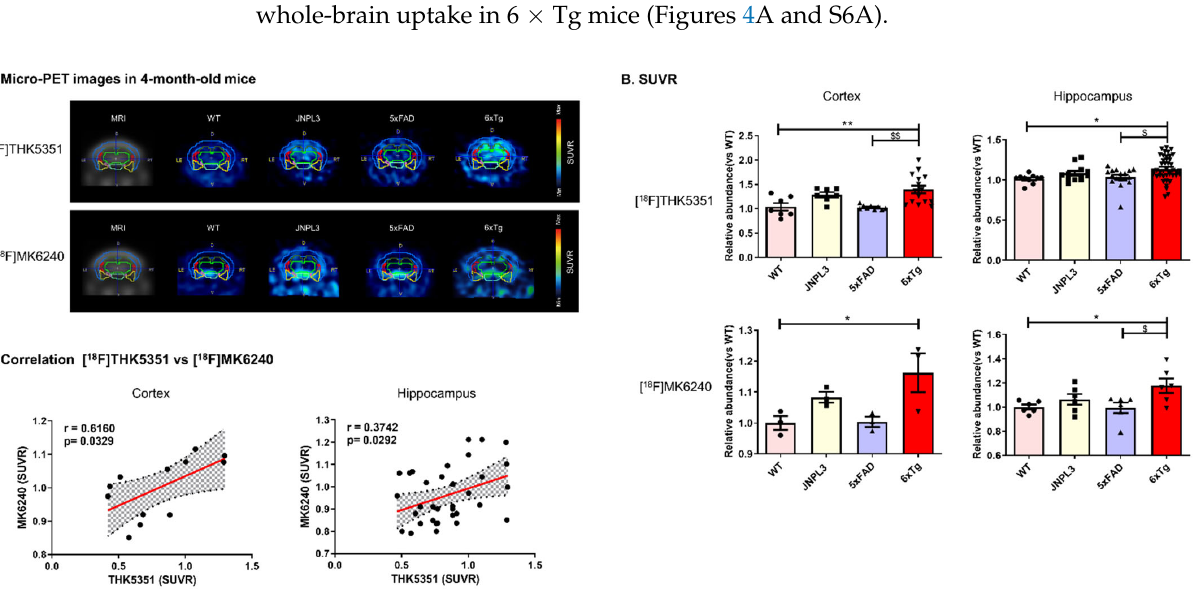
Figure 4. [ 18 F]THK5351 and [ 18 F]MK6240 uptake in the cortex and hippocampus of 4 ‐ month ‐ old 6 × Tg mice brains by in vivo microPET analysis. ( A ) MicroPET images of [ 18 F]THK5351 and [ 18 F]MK6240 radiotracers in the brain. Coronal microPET images summed over 50–60 min after [ 18 F]THK5351 or [ 18 F]MK6240 injection are shown for the WT, JNPL3, 5 × FAD, and 6 × Tg mice. ( B ) ROI ‐ to ‐ cerebellum ratios (ROI = cortex or hippocampus) from [ 18 F]THK5351 (a) or [ 18 F]MK6240 (b) data measured over 50–60 min are calculated for 4 ‐ month ‐ old WT, JNPL3, 5 × FAD, and 6 × Tg mice. Increased [ 18 F]THK5351 or [ 18 F]MK6240 retention is detected in the cerebral cortex and hippocam ‐ pus of 6 × Tg mice compared with that of WT or 5 × FAD mice, but signals in 6 × Tg mice exhibit no significant difference in tau deposition compared with that in JNPL3 mice. All data are presented as the mean ± SEM (n = 3–7 mice per group). Statistical analyses are performed using one ‐ way ANOVA followed by Fisher’s exact test. ** p < 0.01, * p < 0.05 vs. WT, $$ p < 0.01, $ p < 0.05 vs. 5 × FAD. ( C ) The correlation between [ 18 F]THK5351 uptake and [ 18 F]MK6240 uptake is assessed in the cerebral cortex and hippocampus of 6 × Tg mice using nonparametric Spearman’s rank correlation test. Graphs show regression lines with 95% confidence intervals. [ 18 F]THK5351 uptake was significantly correlated with [ 18 F]MK6240 uptake in both the cerebral cortex and hippocampus of 6 × Tg mice. Again, we focused on the mouse cortex and hippocampus. The difference in [ 18 F]THK5351 uptake in the cortex among the 2 ‐ , 4 ‐ , 6 ‐ , and 8 ‐ month ‐ old mice was ex ‐ pressed as the abundance relative to WT mice (Figure S6A). There was a significant in ‐ crease in the accumulation of [ 18 F]THK5351 in the cortex and hippocampus of 4 ‐ , 6 ‐ , and 8 ‐ month ‐ old 6 × Tg mice compared with that in age ‐ matched WT mice (Figure S6B). In addition, [ 18 F]THK5351 uptake in the cortex of 8 ‐ month ‐ old 6 × Tg (1.25 ± 0.01, *** p < 0.001 vs. WT, #### p < 0.001 vs. JNPL3) mice was significantly higher than that in age ‐ matched JNPL3 (1.20 ± 0.02) mice (Figure S6B). In 4 ‐ month ‐ old 6 × Tg mice (1.18 ± 0.04, ** p < 0.01 vs. WT, # p < 0.05 vs. JNPL3), [ 18 F]THK5351 was detected at a higher abundance in the hippocampus than in age ‐ matched WT (1.0 ± 0.02) or JNPL3 (1.2 ± 0.01) mice (Figures 4B and S6B).